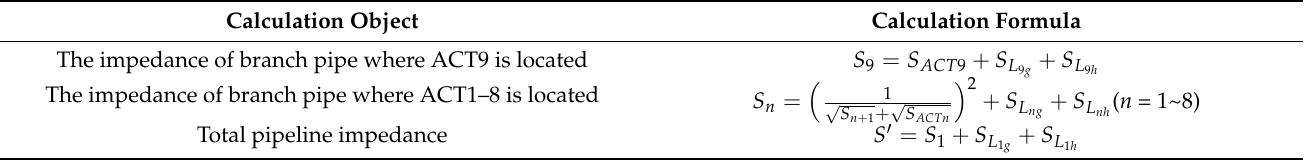
Table 4. Impedance calculation formula. The unit of the impedance is s 2 /m 5 .